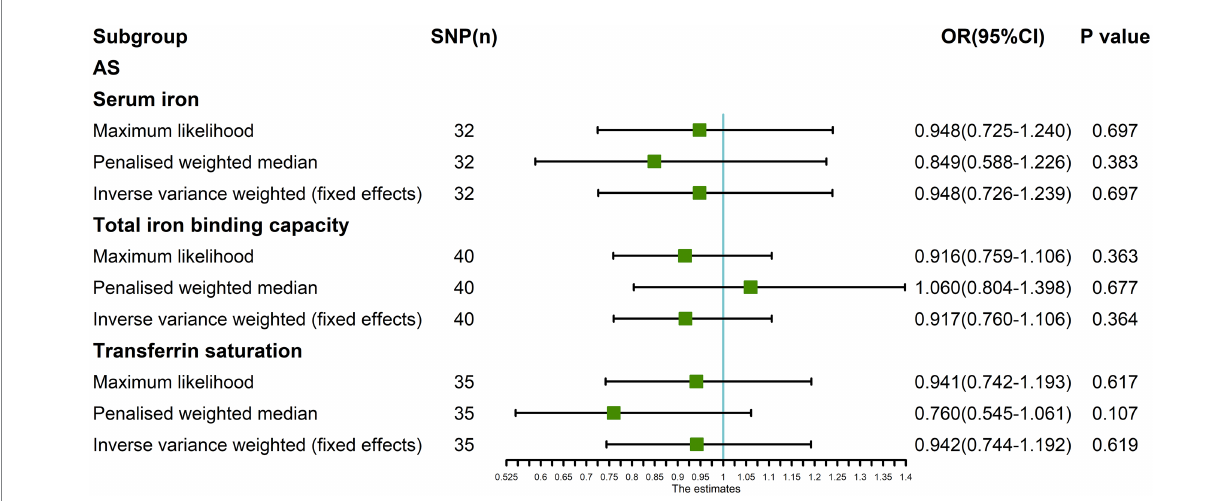
FIGURE 8 The MR analysis between three exposures (serum iron, total iron binding capacity, transferrin saturation) and outcomes (ankylosing spondylitis) after exclusion of outlier SNPs detected by MR-PRESSO. Three methods: Maximum likelihood, penalized weighted median, and IVW (fixed effects).